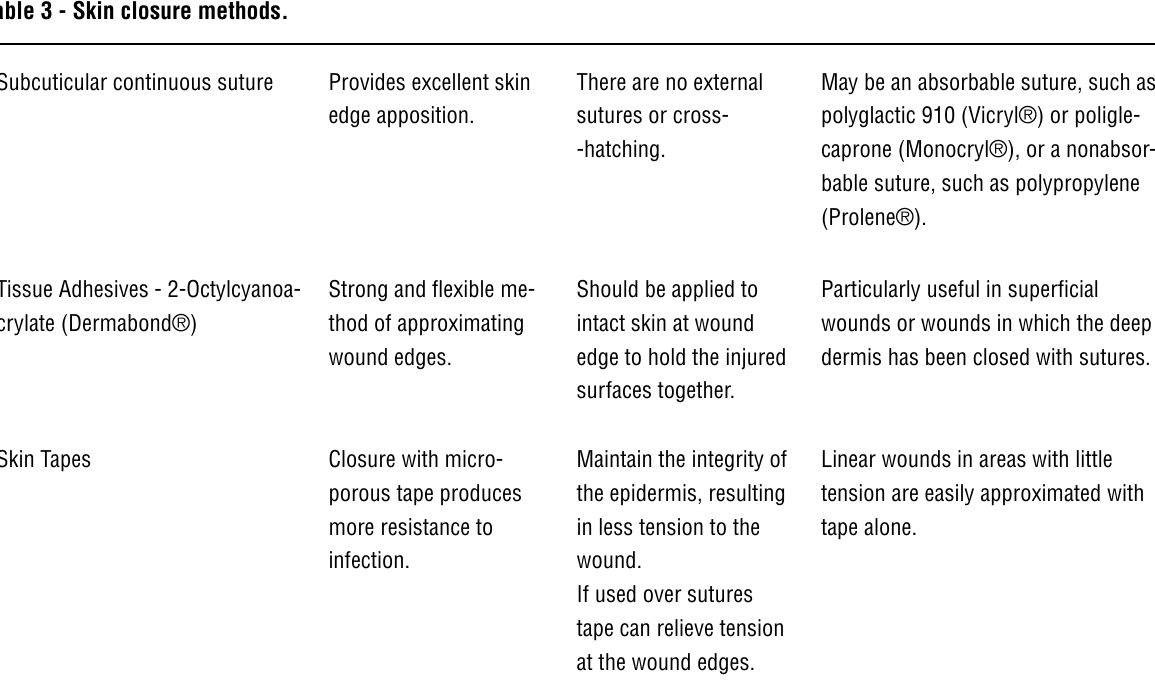
Table 3 - skin closure